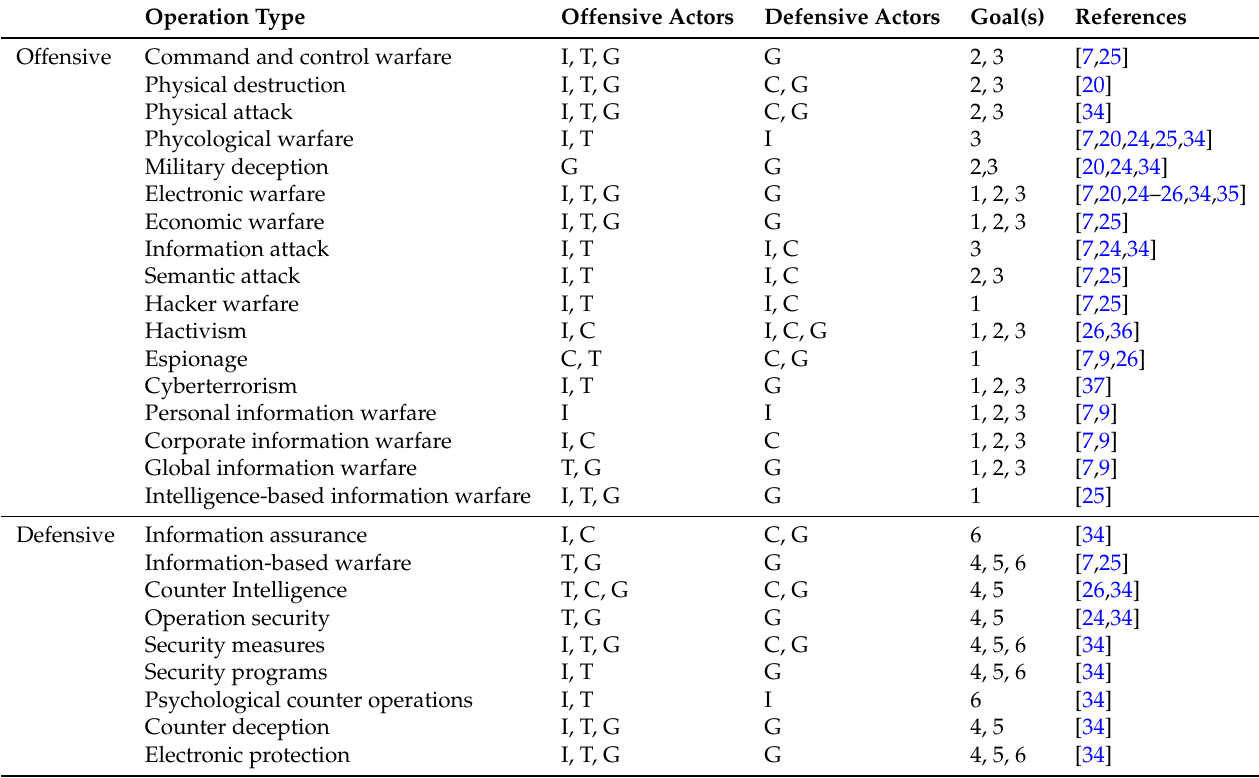
Table 2. Summary of information warfare